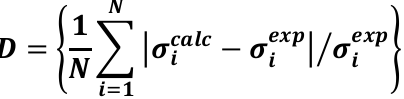
Table 2: Statistical analysis of 47,48,50 Ti (n, α) reaction cross-sections. The weighted deviation (F)